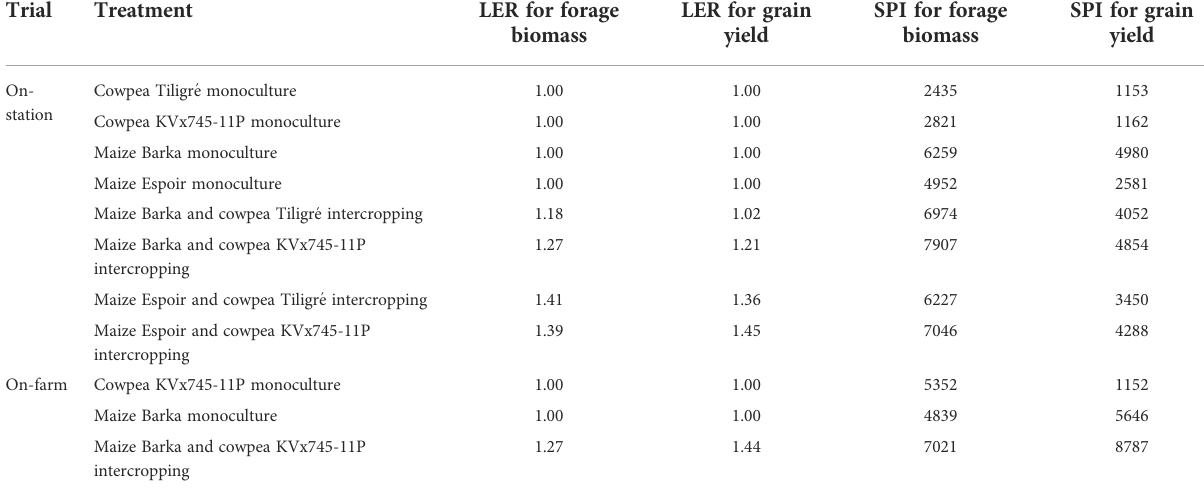
LER for grain SPI for forage SPI for grain biomass yield biomass yield